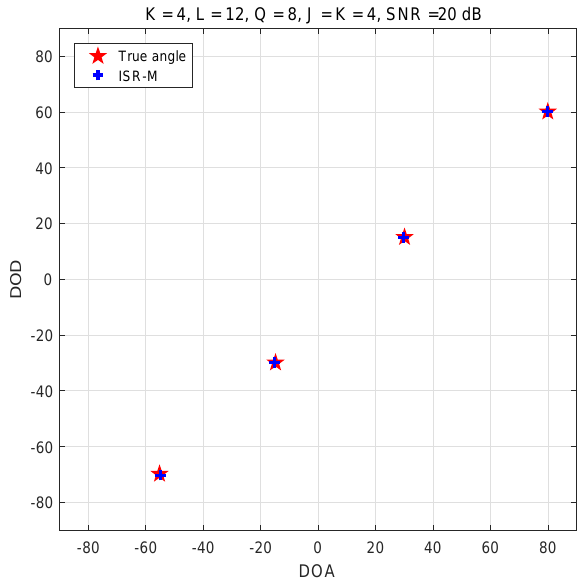
Figure 7. Target localization performance of the proposed ISR-M method, J = K =